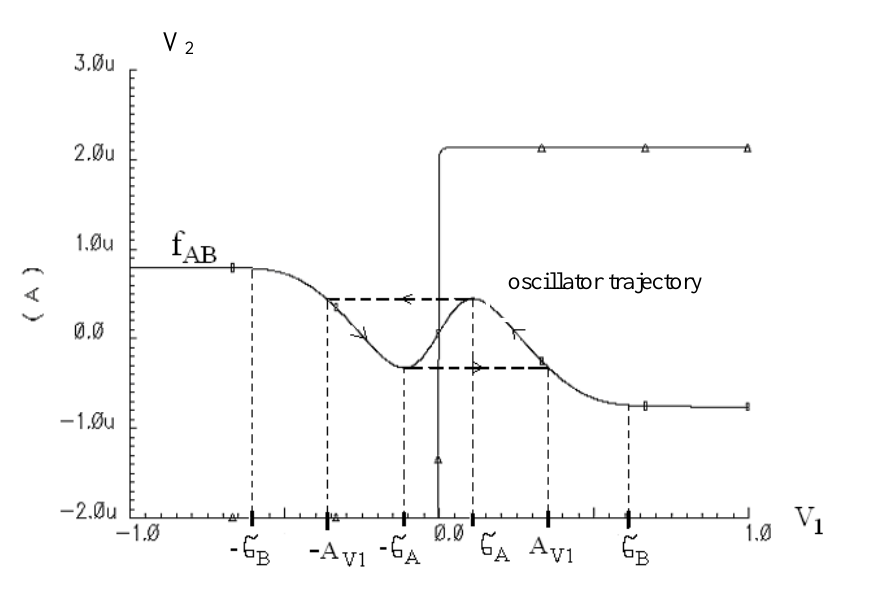
Figure 13. Nullclines and trajectories (dashed line) for single relaxation